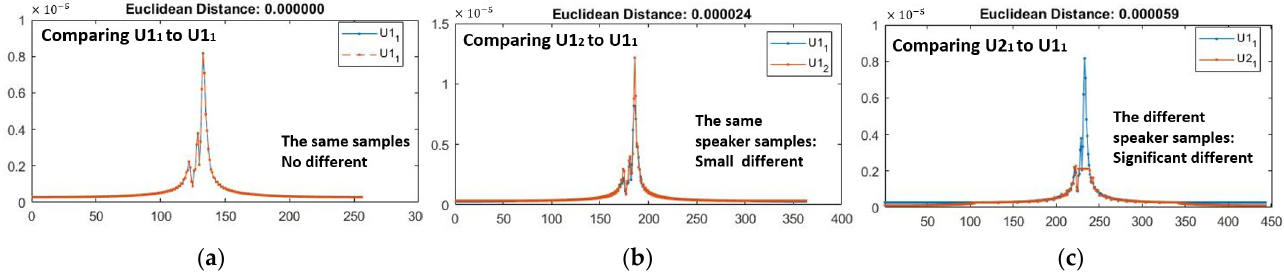
Figure 7. A comparison of the three enveloped reflected signals in the frequency domain is made when U1 and U2 pronounce the vowel “a”: ( a ) Comparing the same sample of U1; ( b ) Comparing two samples of the same passphrase of U1; ( c ) Comparing the same passphrase of U1 and U2.